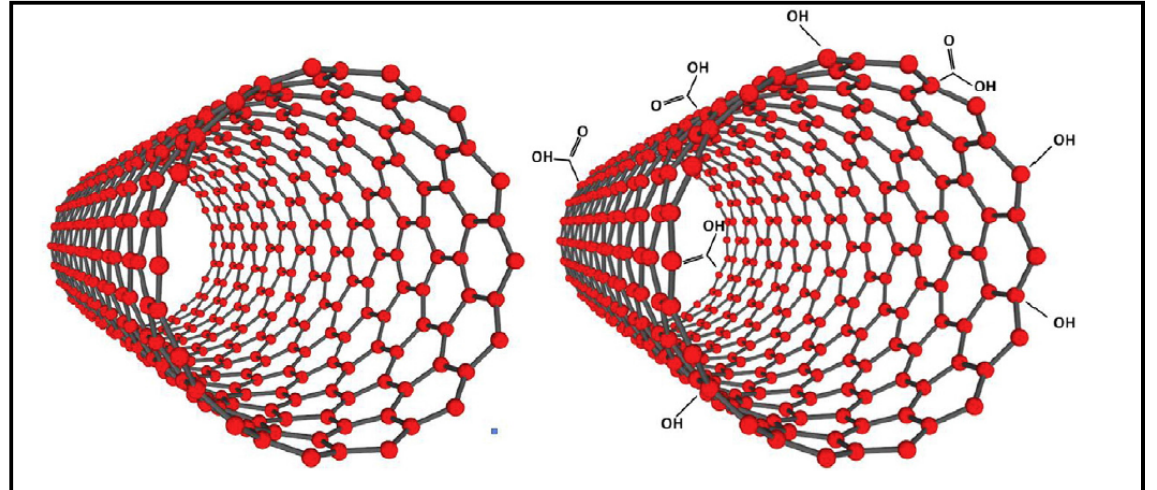
Figure 12. The oxidized multiwall carbon nanotubes (MWCNT) surface with acid mixture. Reprinted with permission from ref. [55]. © 2015 Elsevier B.V.